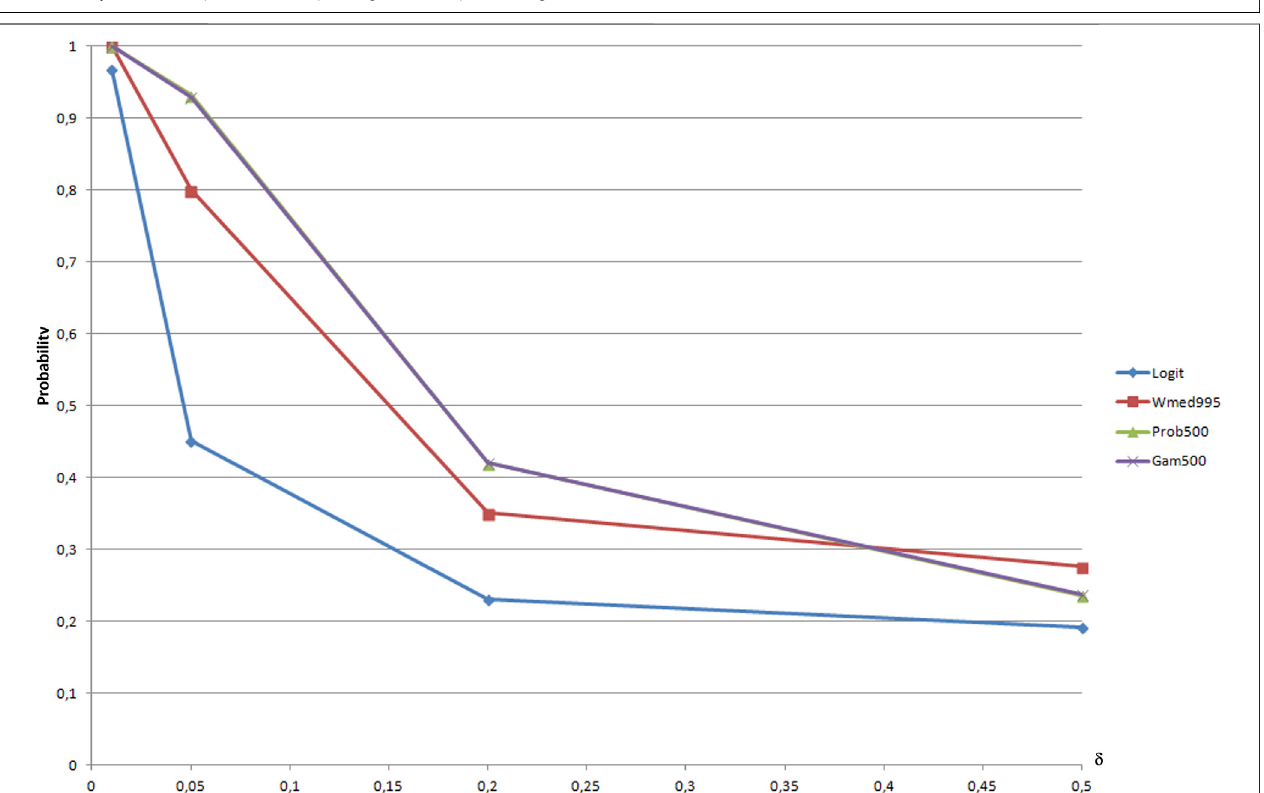
FIGURE 4 | Path choice probabilities depending on Cv for path 0: Logit vs. Weibit, Probit, and Gammit best models.